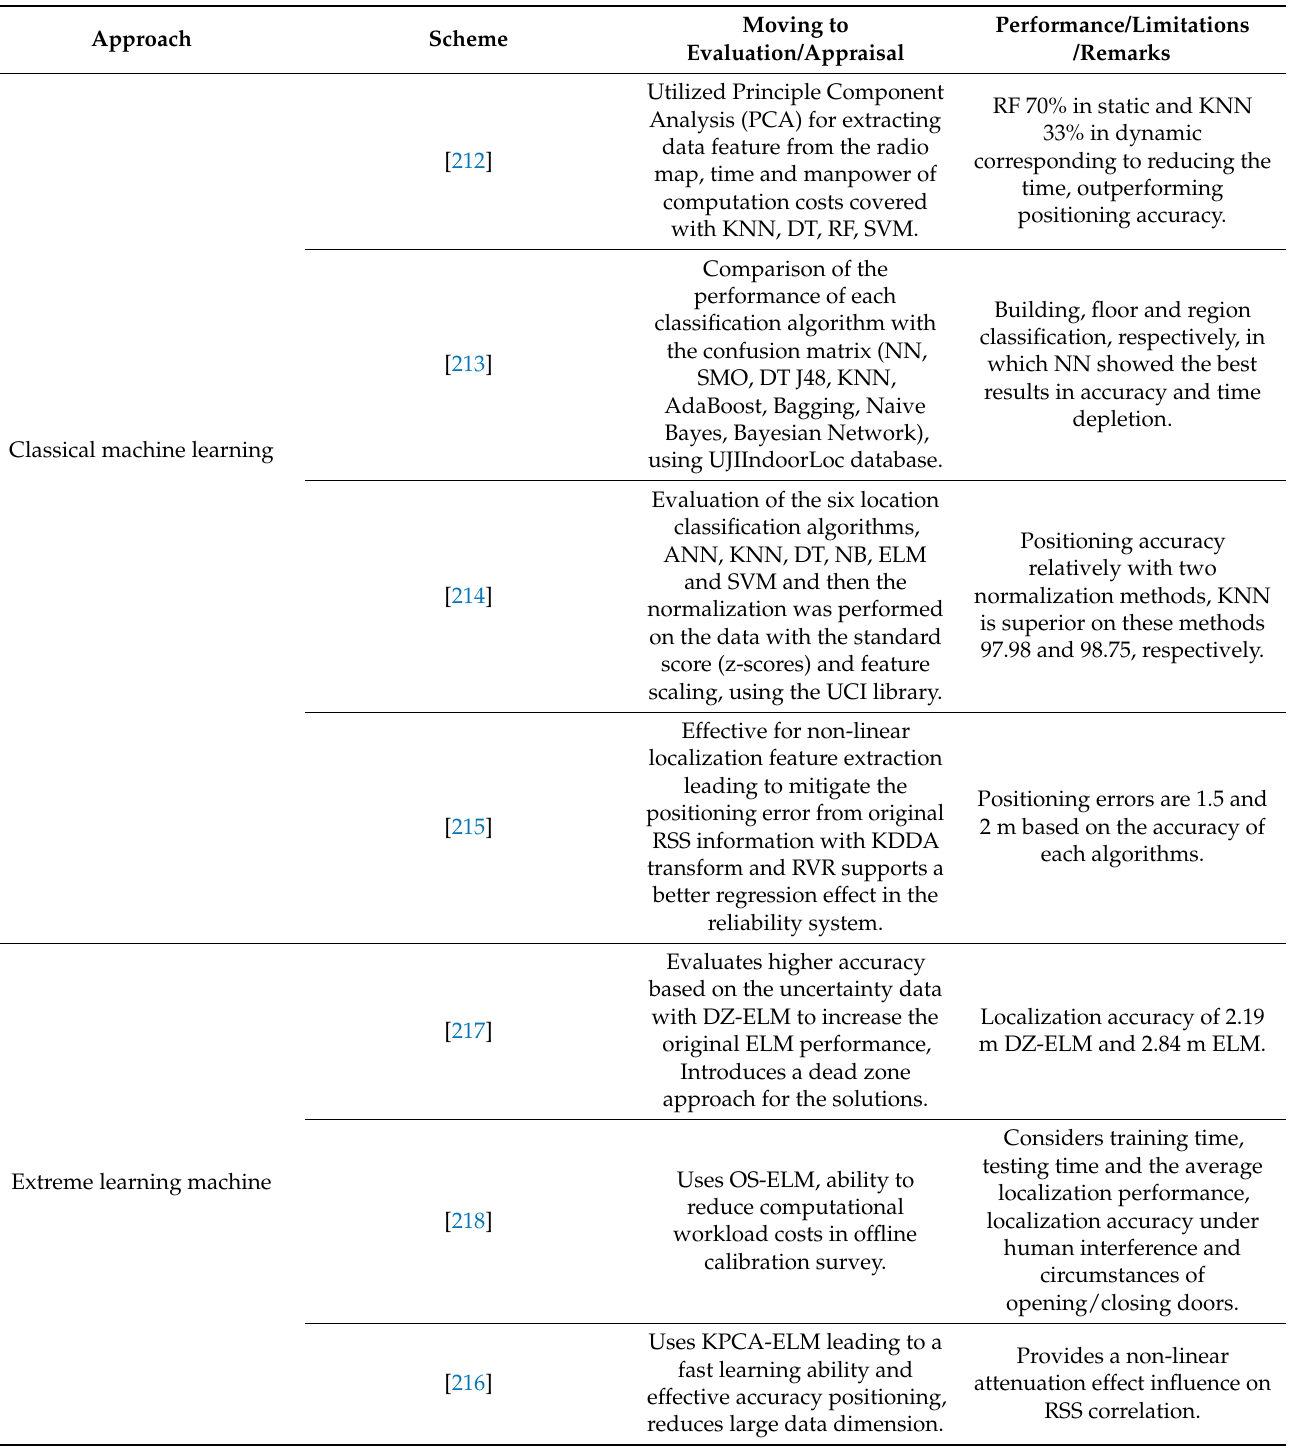
Table 6. Performance based on machine learning algorithms and extreme learning machine